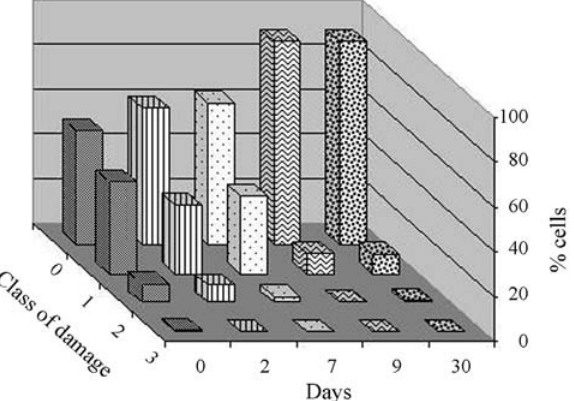
Figure 4 - Frequency of DNA damage in hemolymph cells at different re- covery times after treatment with methylmethane sulfonate (MMS). For each point 500 cells from five replicates were